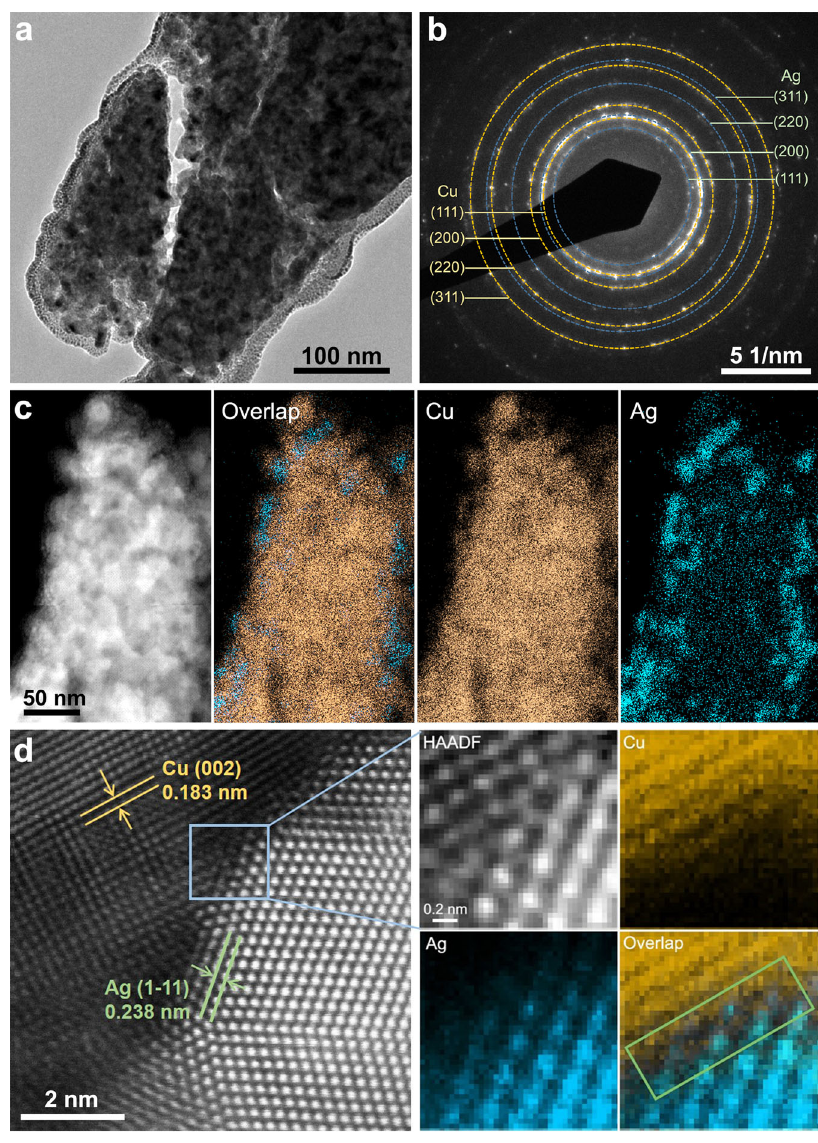
Fig. 4 | Structural characterization of Cu(OD) 0.8 Ag 0.2 catalyst after CO reduc- tion reaction. a TEM image of Cu(OD) 0.8 Ag 0.2 catalyst cross-section cut by FIB. b ElectrondiffractionpatternofCu(OD) 0.8 Ag 0.2 catalystshownin a . c HAADF-STEM image and corresponding EDS mapping of Cu and Ag. d HAADF-STEM image and